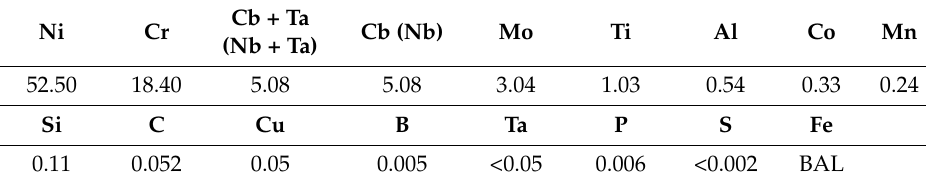
Table 1. Chemical composition (wt %) of the Inconel 718 substrate [12].